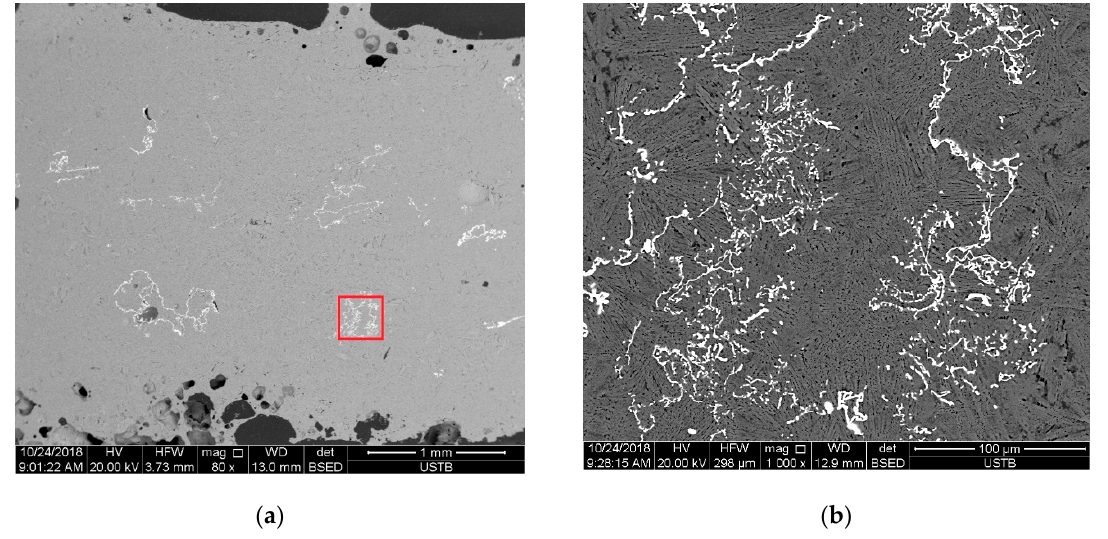
Figure 8. The micrographs of samples with MoO 3 % = 2%: ( a ) low-magnification micrograph; ( b ) enlarged micrographs. ( b ) enlarged